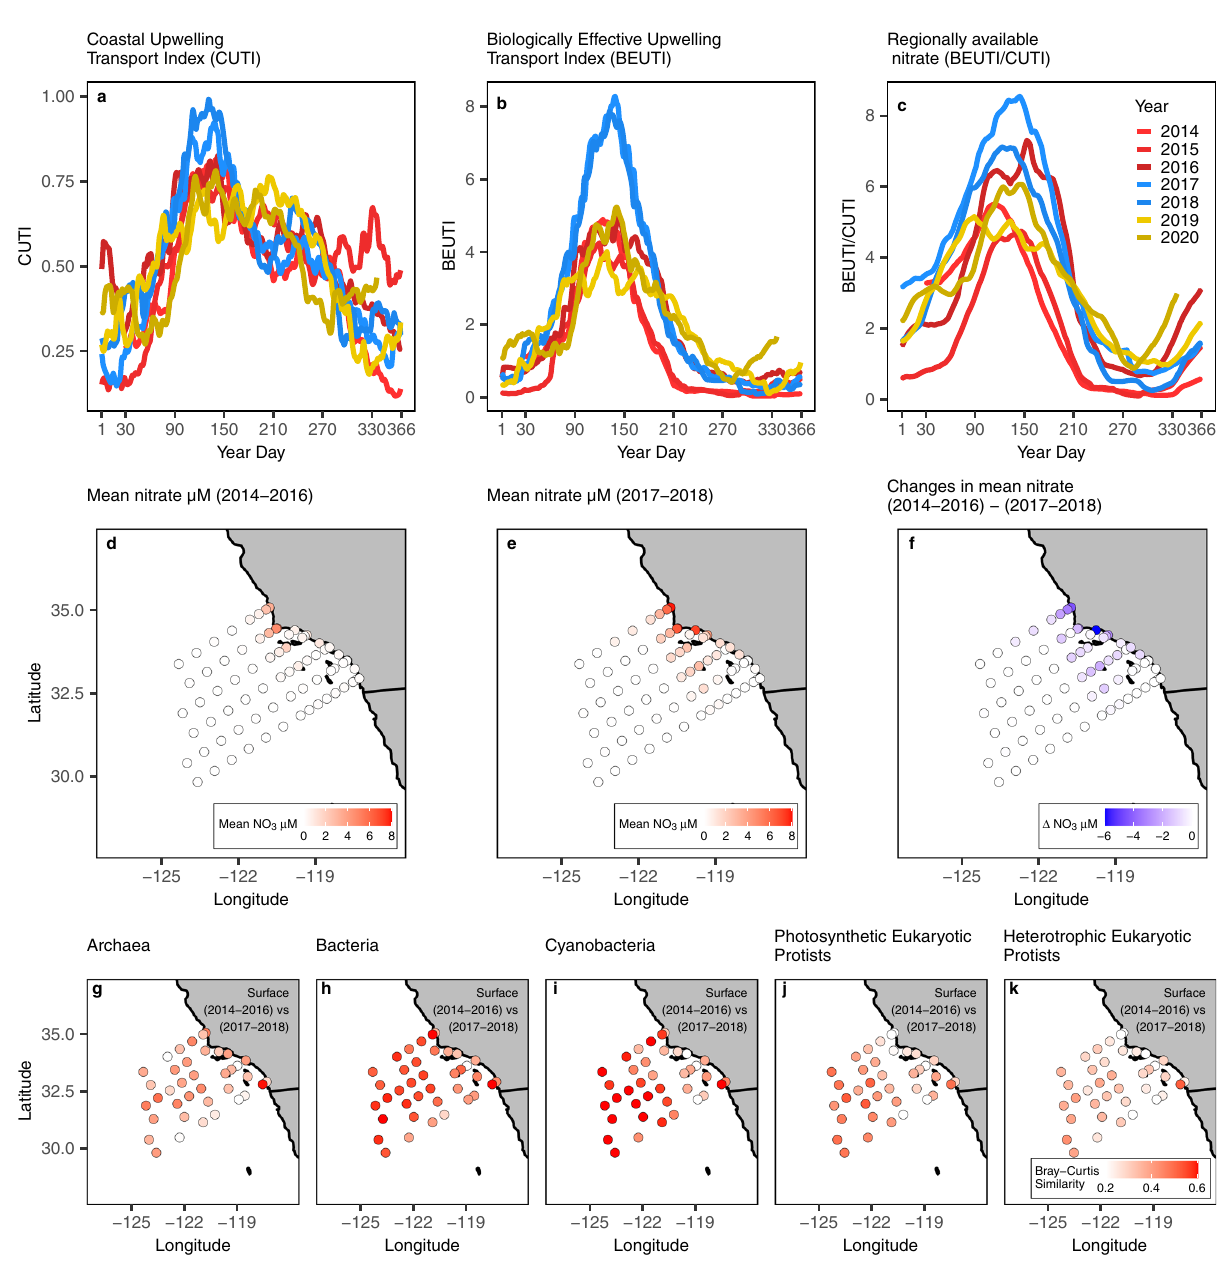
Fig. 5 Physical and ecological changes in the region across time. a Annual cycle of Coastal Upwelling Transport Index (CUTI). b Biologically Effective Upwelling Transport Index (BEUTI). c Regionally available nitrate for the studied time period (2014-2020). Lines are 2-month moving averages and the color palettes represent three distinct time periods, 2014 – 2016 (red), 2017 – 2018 (blue), and 2019 – 2020 (gold). CUTI (m 2 s − 1 ) is a regionally integrated rate of vertical volume transport. BEUTI ( μ M m − 1 s − 1 ) is an estimate of nitrate fl ux into the surface mixed layer. Regionally available nitrate ( μ M) is the concentration of nitrate at the base of the mixed layer and can be calculated by dividing BEUTI by CUTI (see Jacox et al. 2018 47 for a full explanation). d Mean nitrate ( μ M) concentrations at 10 m depth at each CalCOFI station during the warm period (2014 – 2016). e mean nitrate concentrations during the cool period. f The difference in nitrate concentrations between the two phases (2014 – 2016) – (2017 – 2018). g – k Maps of the mean Bray-Curtis similarity 92 between samples from the warm (2014 – 2016) and cool (2017 – 2018) phase for each station. Maps show surface samples for our fi ve main groups ( g Archaea, h Bacteria, i Cyanobacteria, j Photosynthetic Eukaryotic Protists, and k Heterotrophic Eukaryotic Protists). For DCM samples, see Supplementary Fig.